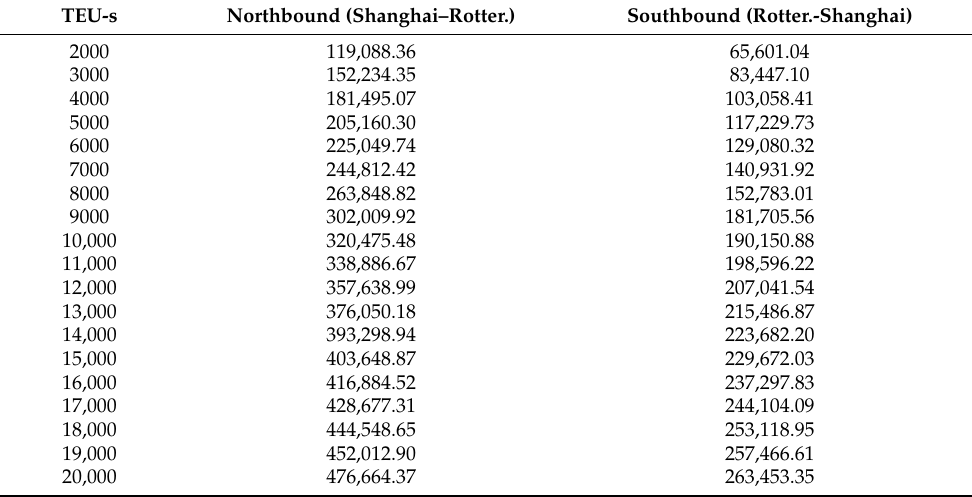
Table A2. Suez Canal toll estimates in US $.